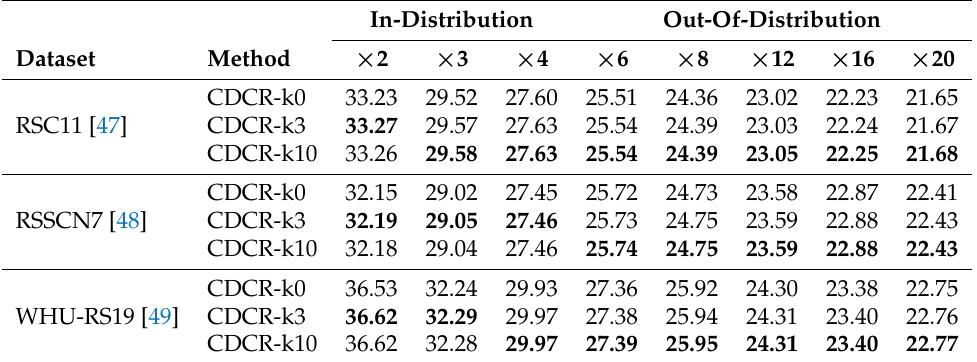
Table 3. Ablation experiment on pre-modulation in resolution-specific refinement. -k0 indicates the absence of pre-modulation, while -k3 and -k10 indicate the integration of 3 and 10 experts for pre- modulation. The optimal PSNR values for each scale factor across different datasets are emphasized in bold .